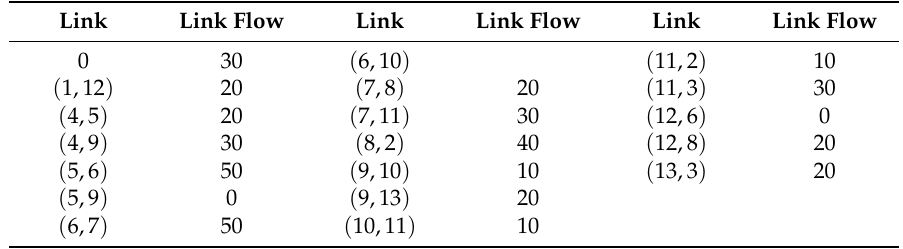
Table 6. OD Energy recharged.